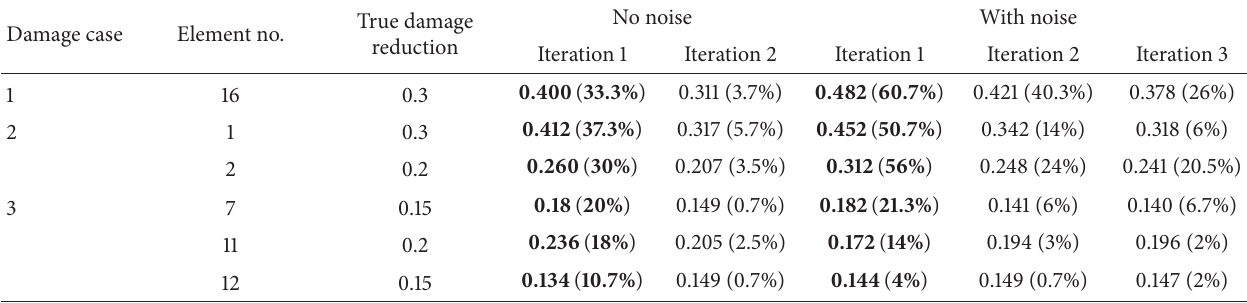
Table 3: Results of the calculated damage parameters in [13] (Example 2).